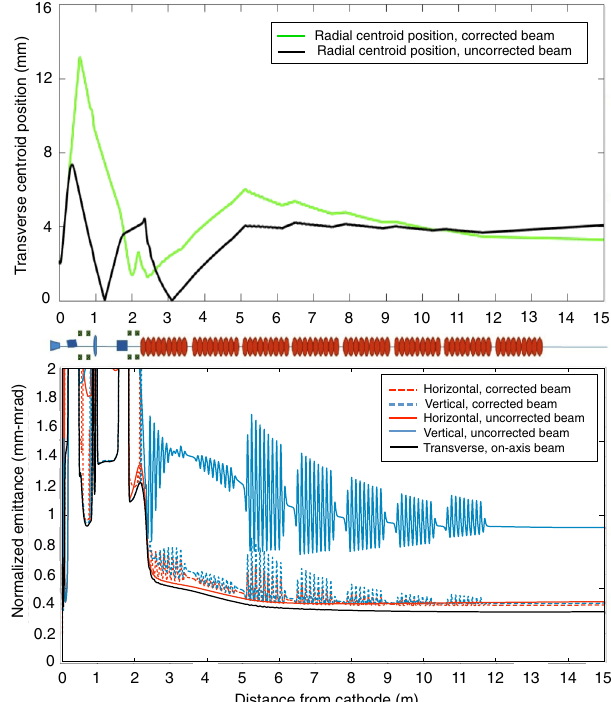
FIG. 10. Simulation of a beam emitted 2 mm off-axis at the cathode, with space charge included. Top: Beam centroid position along the beam line for the optimally corrected (green line) and noncorrected (black line) cases. Bottom: Normalized transverse emittance evolution along the beam line for the optimally corrected (dashed lines) and noncorrected (solid lines) cases. Red and blue curves are used to identify the horizontal and vertical planes,